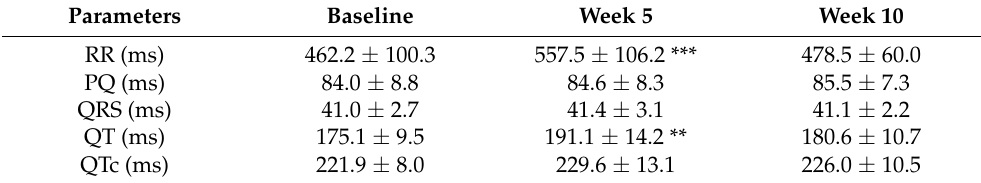
Table 2. Electrocardiography parameters obtained from seven dogs at baseline, week 5, and week 10 after exposure to EMR from MPs.